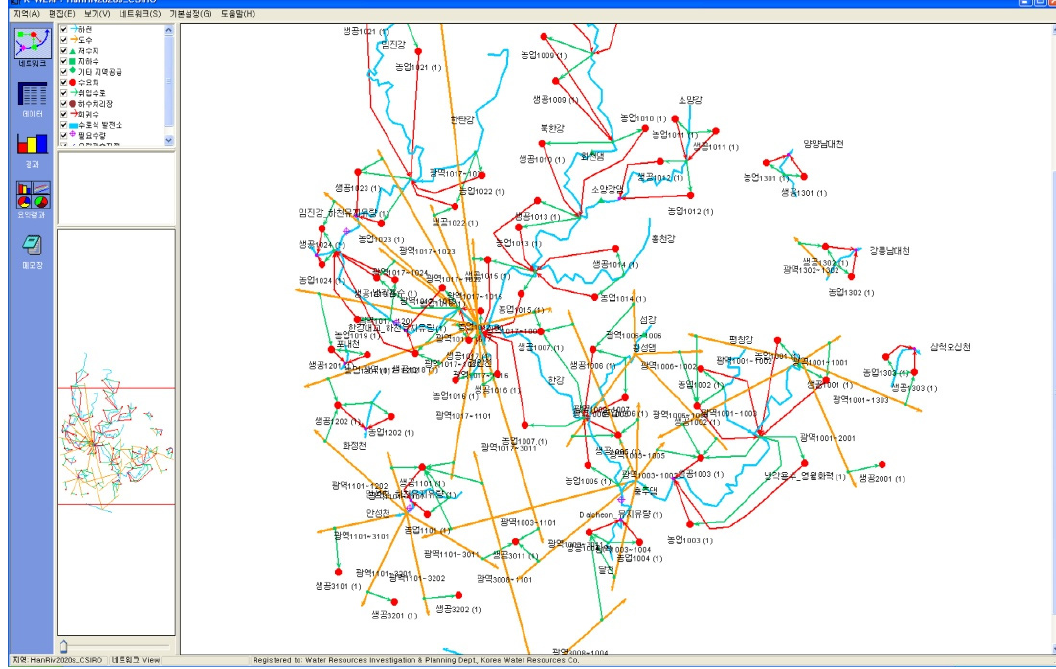
Figure 3. Schematic network of the Han River basin, the K-WEAP